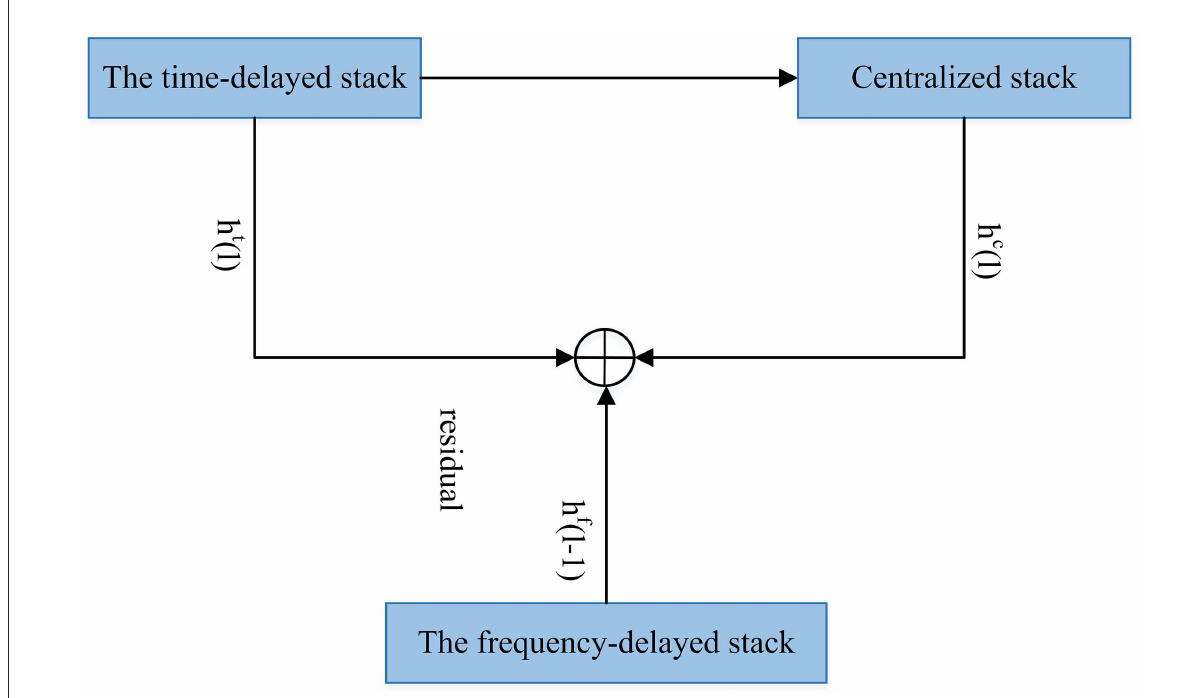
FIGURE8 MelNet. The model gives the input to the three aforementioned stacks. The stacks extract features from different input sections to collectively summarize the entire